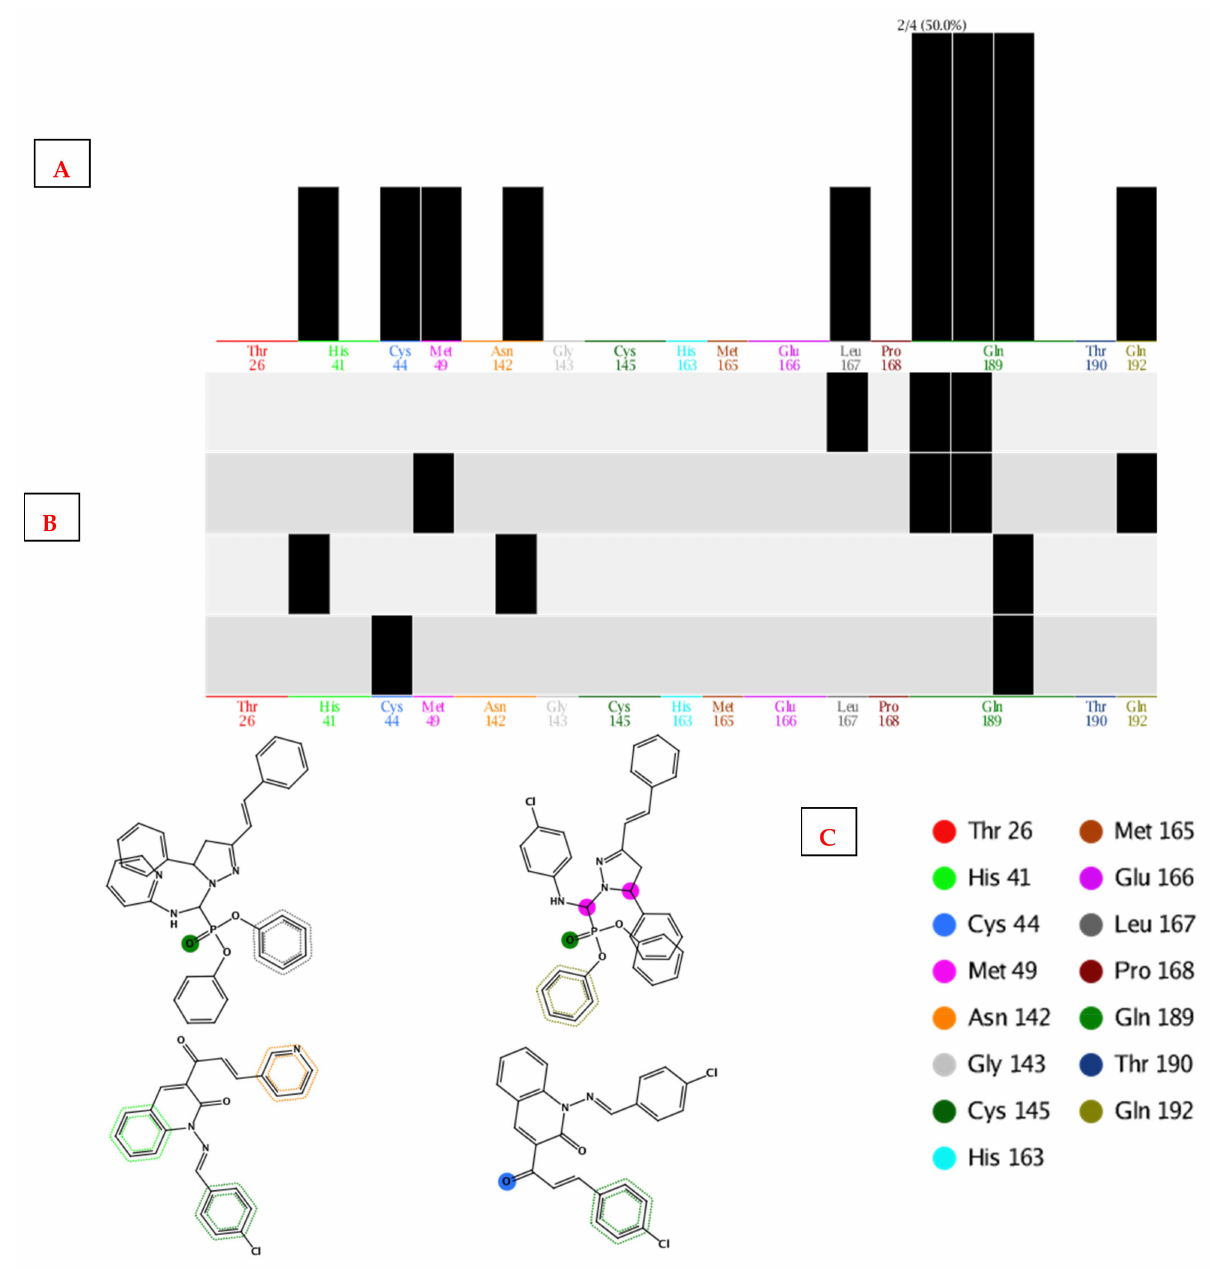
Figure 7. ( A ) PLIF histogram plotted, ( B ) statistical key interaction, ( C ) interaction key for ( 7a , 7b , 15a , and 15b ) with active